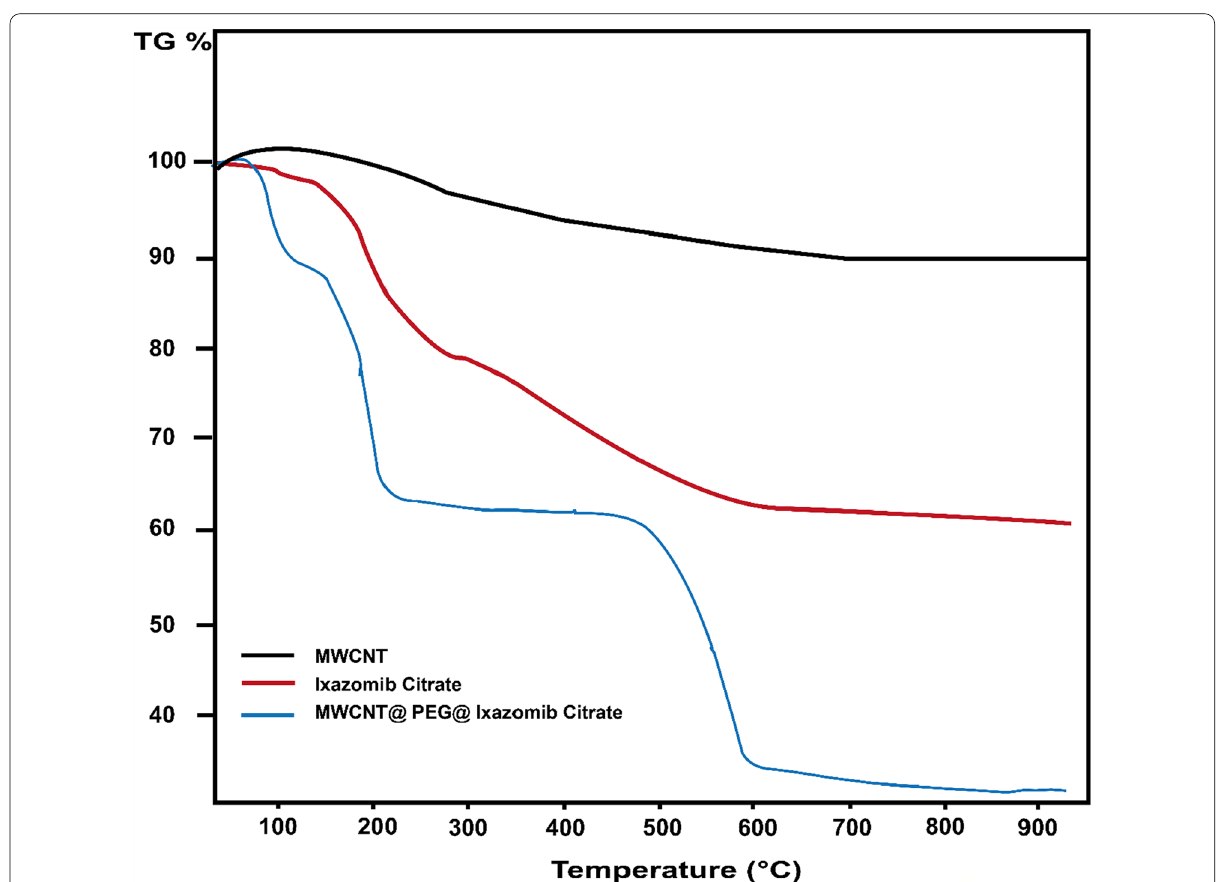
Fig. 6 The TGA analysis for Ixazomib citrate, MWCNT, and the composite